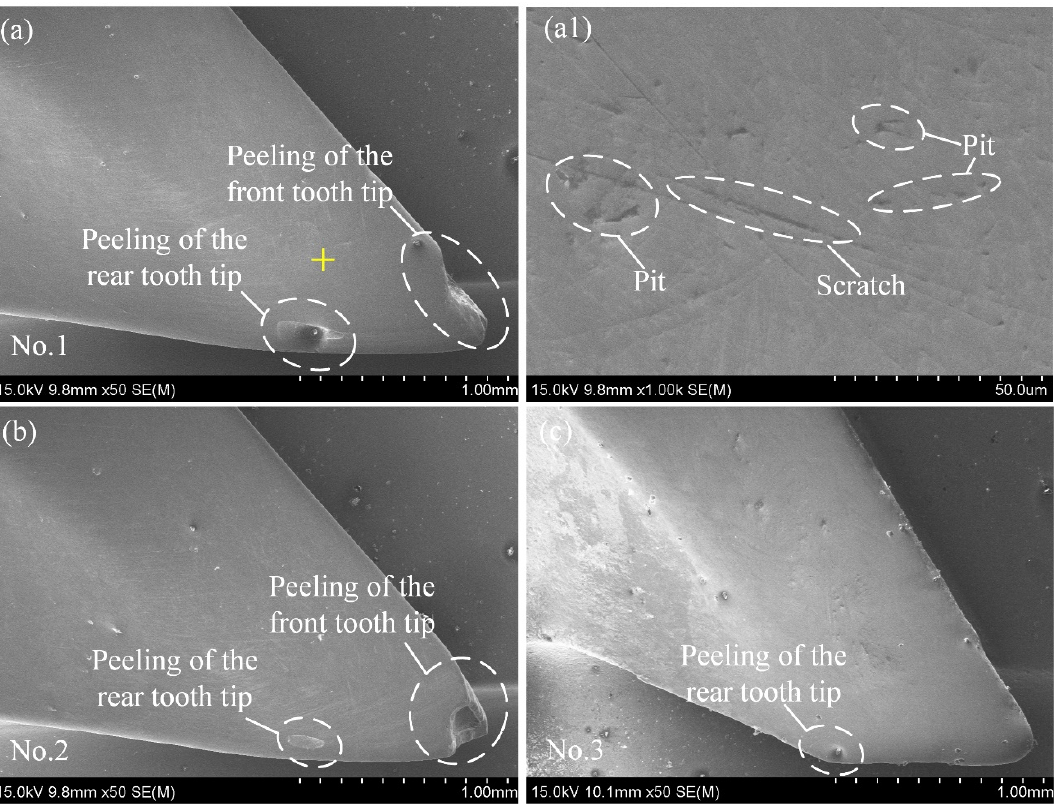
Figure 6. Wear morphology of hook teeth nos. 1 to 3 in a 150-hectare operation: ( a – c ) Wear morphology of hook teeth nos. 1 to 3; and ( a1 ) partial micrograph of the hook tooth nos. 1 mark.